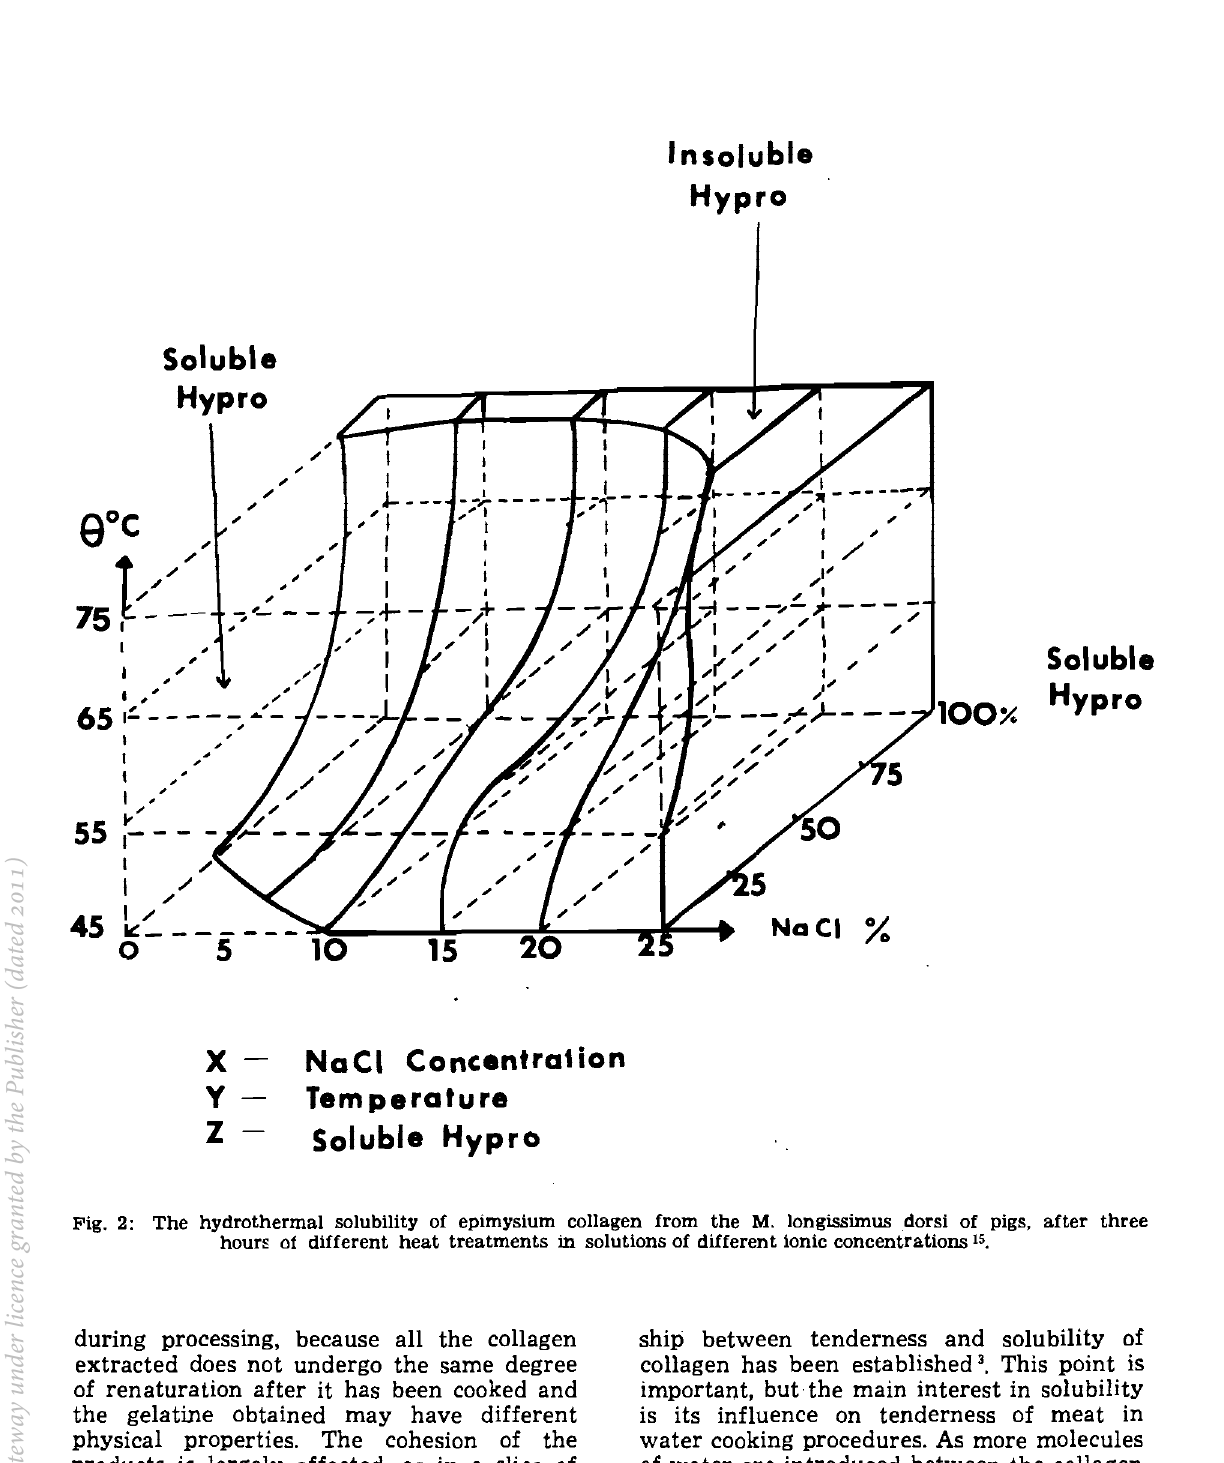
during processing, because all the collagen extracted does not undergo the same degree of renaturation after it has been cooked and the gelatine obtained may have different physical properties. The cohesion of the products is largely affected, as in a slice of ham, for instance. In fresh meat prepared by the same dry cooking procedure a direct but low relation-